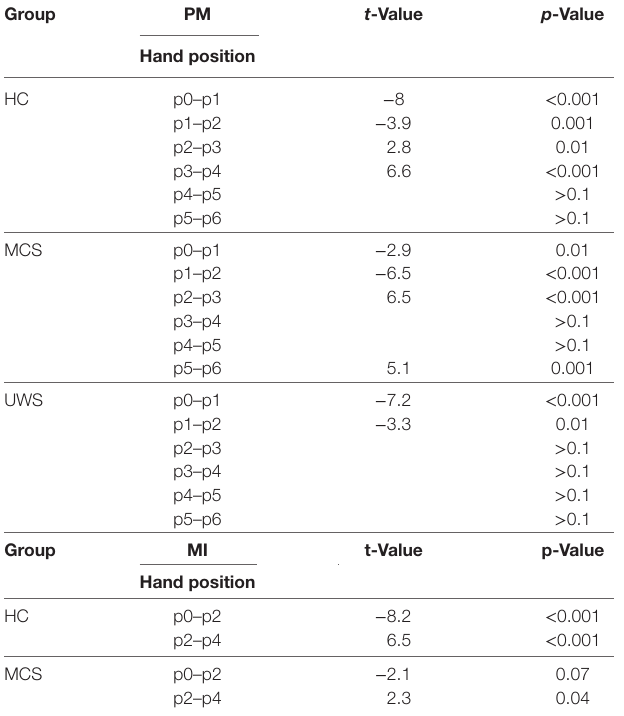
Table 2 | Post hoc t -test concerning pulsatility index modulation at each hand position (p) as compared to the previous one (significant when p -value < 0.0125), during the passive motor (PM) and motor imagery (MI) task in patients with minimally conscious state (MCS) and unresponsive wakefulness syndrome (UWS), and in healthy controls (HC). MI data of patients with UWS were not significant. group PM t -Value p -Value